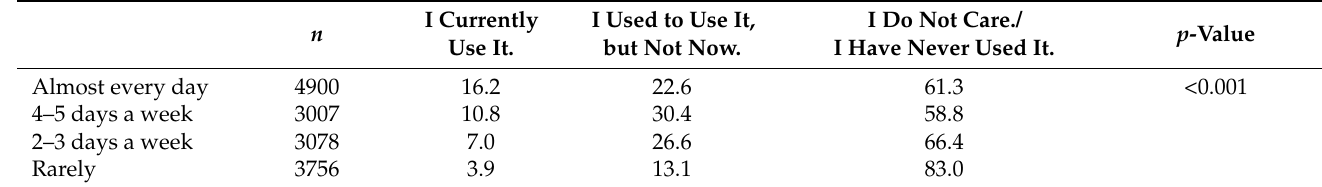
Table 3. The prevalence of vitamin-fortified food usage and reasons for non-usage.